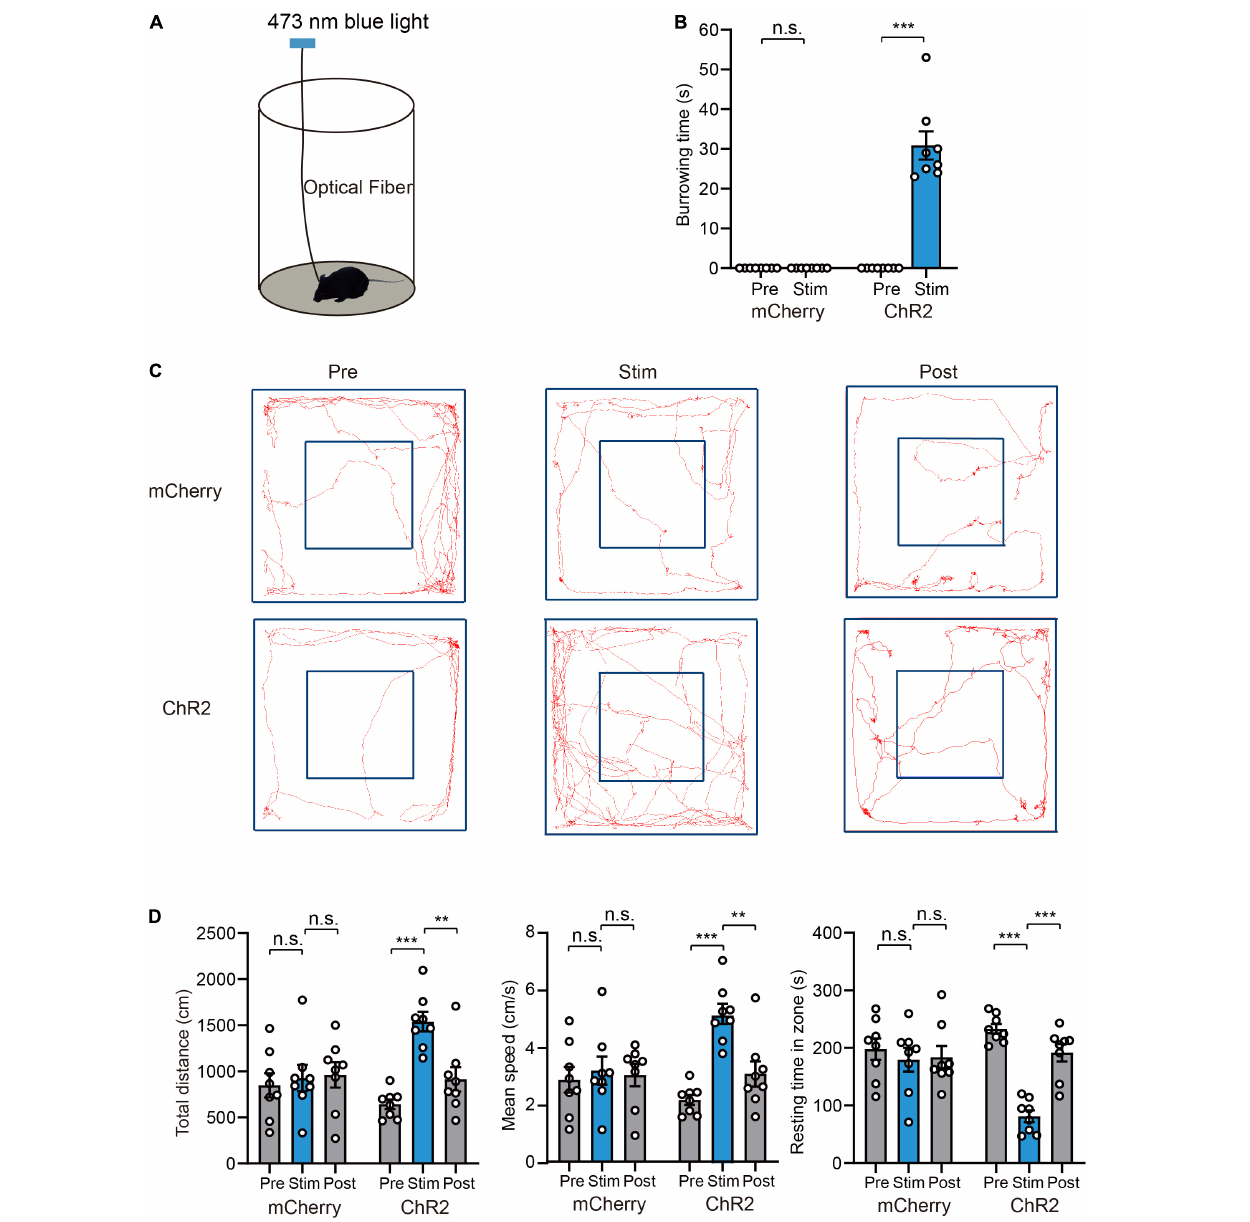
FIGURE 2 | Photoactivation of VTA glutamatergic neurons promotes burrowing and fleeing behaviors. (A) Schematic of the home-cage test. (B) The total burrowing time upon stimulating VTA glutamatergic neurons in the home-cage test [ n = 8 ChR2 vs. n = 8 mCherry; two-way repeated-measures ANOVA, virus × stimulation, F (1,14) = 76.38, P < 0.001, Bonferroni post hoc comparison]. (C) Examples of tracking traces of mice in open field tests. (D) Photostimulation of VTA glutamatergic neurons influenced total distance, mean speed and resting time in open field experiments [ n = 8 ChR2 vs. n = 8 mCherry; two-way repeated-measures ANOVA, virus × stimulation, F (2,28) = 10.35, P = 0.004, F (2,28) = 9.747, P = 0.0006, F (2,28) = 13.70, P < 0.001, Bonferroni post hoc comparison]. Data are expressed as mean ± SEM. ** P < 0.01, *** P < 0.001, n.s., not